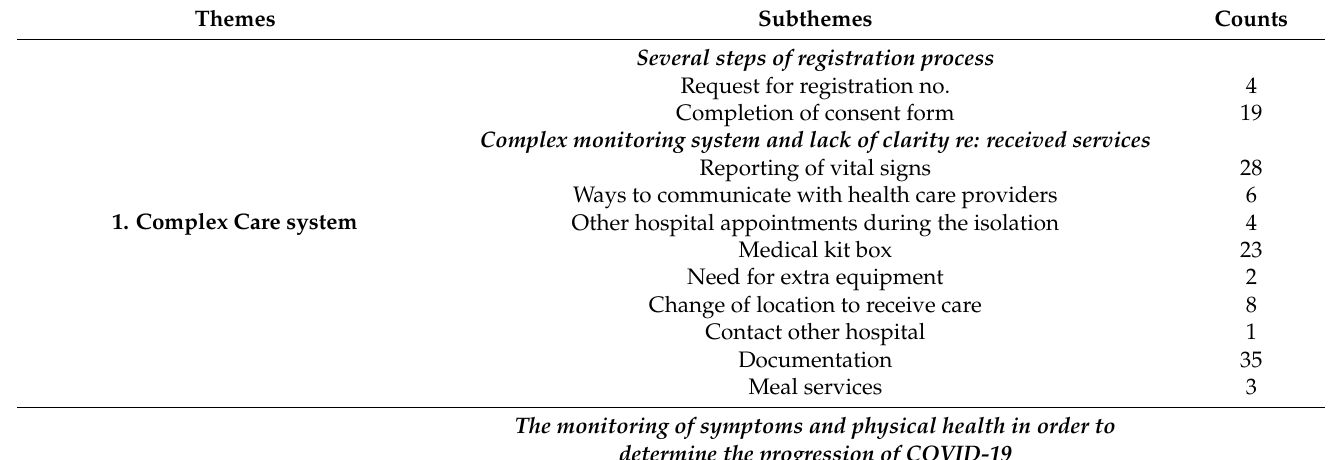
Table 1. Themes, subthemes and numbers of questions per